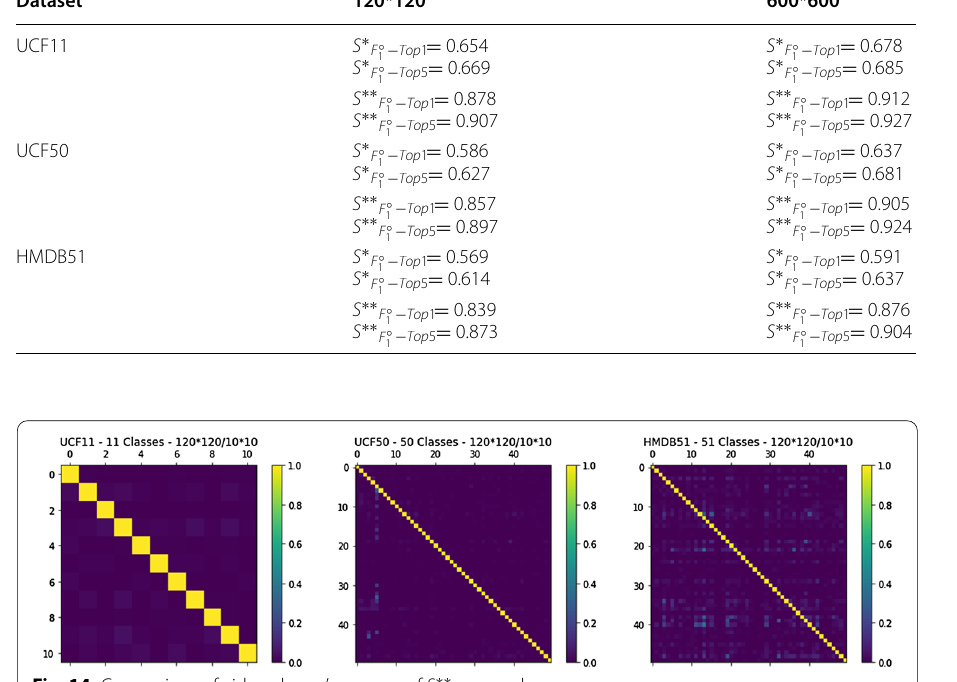
Table 7 F1‑Score comparison of S ∗ and S ∗∗ Dataset